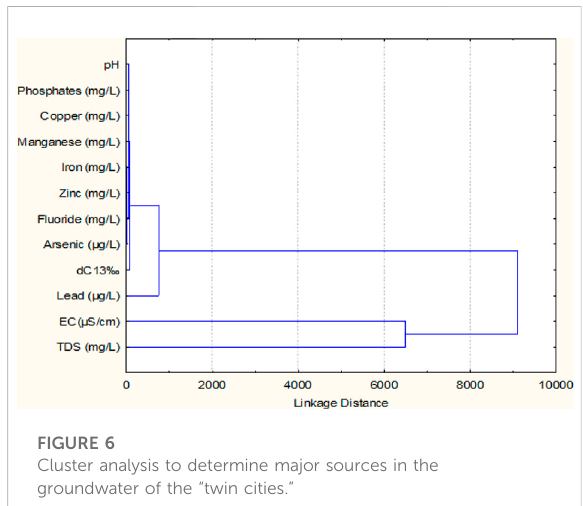
FIGURE 6 Cluster analysis to determine major sources in the groundwater of the “ twin cities.